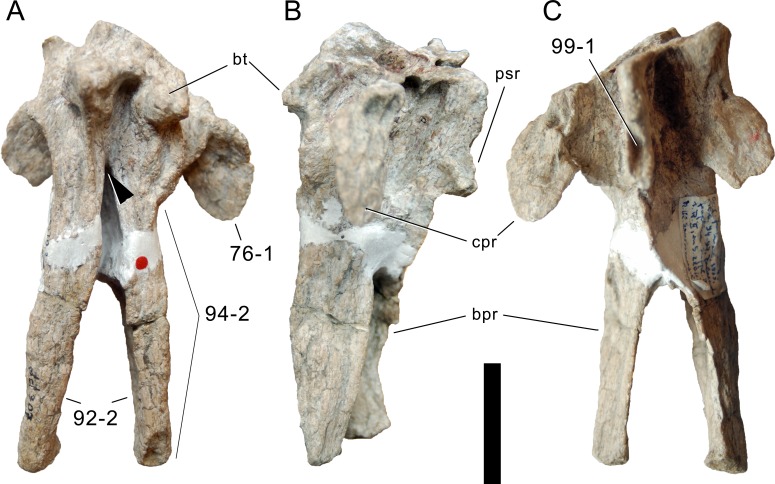
Basal tubera and basisphenoid of Dicraeosaurus hansemanni MB.R.2379 in posteroventral (A), left lateral (B), and anterodorsal view (C).Note the lateral expansion of the anteroventral end of the crista prootica (C76-1), the narrowly diverging, and elongate basipterygoid processes (C92-2 and C94-2, respectively), the deep slot-like cavity separating the bases of the processes (A, arrowhead; C95-1), and the groove on the dorsal surface of the parasphenoid rostrum (C; C99-1). Abb.: bt, basal tuber; bpr, basipterygoid process; cpr, crista prootica; psr, parasphenoid rostrum. Scale bar = 5 cm.